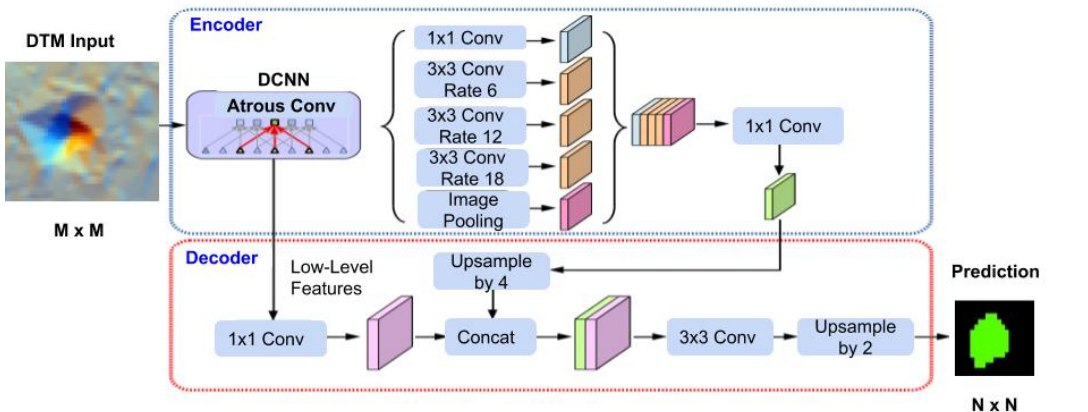
Figure 1. Architecture of DL4DTM. As opposed to DeepLabv3+, the output dimension is, N = M upsampling is done with a factor 2 rather 4 . The rest of the model is exactly the same as DeepLabv3+